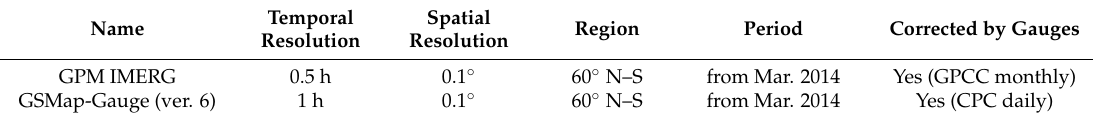
Table 1. Brief summary of the two latest satellite-based precipitation products used in this study.